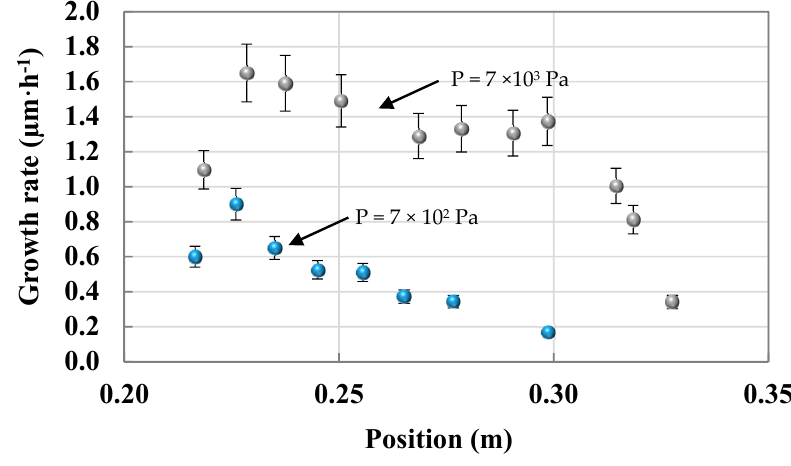
Figure 3. Evolution of the growth rate along the 20 cm substrate placed in the tube (30 mm in diameter) for two different pressures: Same experimental conditions as in Figure 2 for temperature and N 2 flow rate; BBC flow rate is 0.8 and 3 sccm (0.16% and 0.6%).